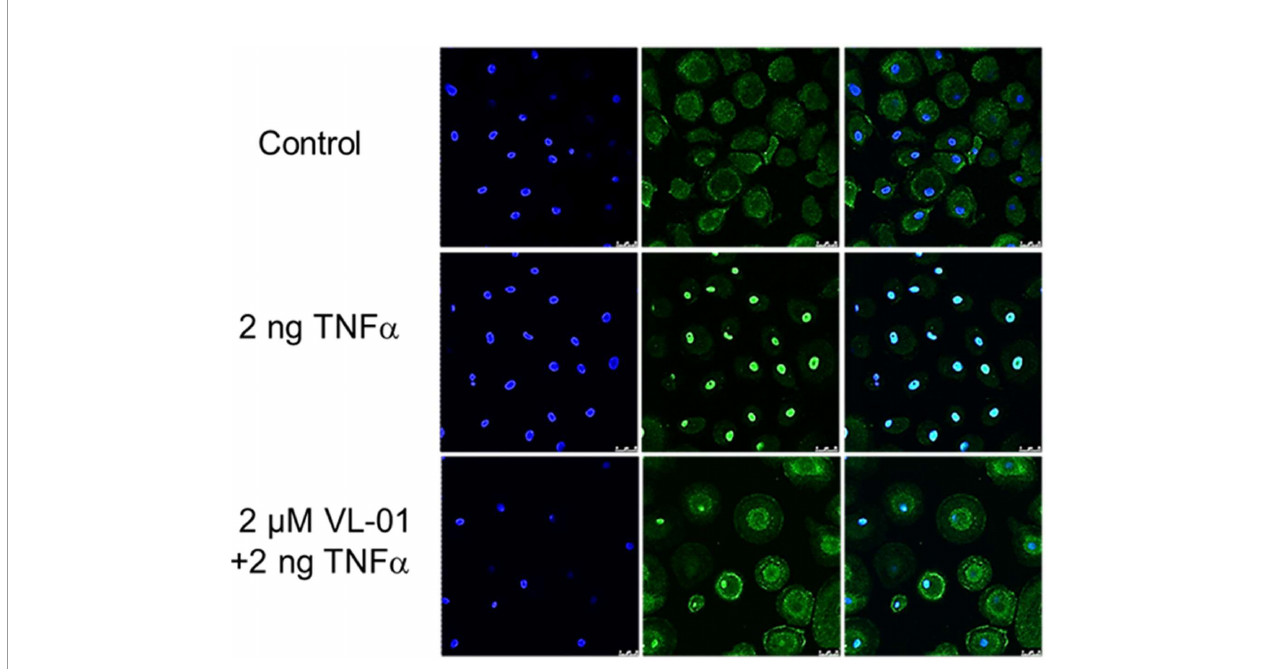
FIGURE 2 | Inhibition of TNF a induced nuclear translocation of NF- k B by the proteasome inhibitor VL-01. Human monocyte-derived macrophages were seeded on cover-slides, incubated overnight, and incubated in the presence or absence of the proteasome inhibitor VL-01 and stimulated with TNF a (2 ng/ml) for 30 min. Immuno fl uorescence staining of NF- k B was done using a FITC (green)-labeled p65 speci fi c antibody (middle panel), and cell nuclei were counterstained with DAPI (blue, left panel) and evaluated by confocal microscope (Leica, LSM3). Staining of NF- k B (FITC) and nuclei (DAPI) superimposed are shown in the right